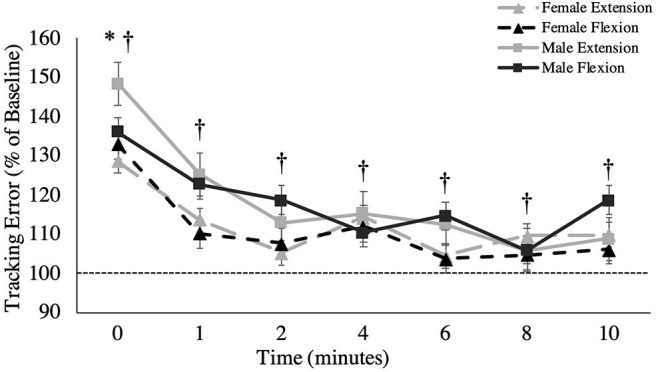
Overall tracking error (percentage of baseline) across recovery time points. The dashed line represents baseline tracking error. This metric is presented as group averages (with standard error bars). † = data are significantly different between sexes; * = pooled data are significantly different from baseline.